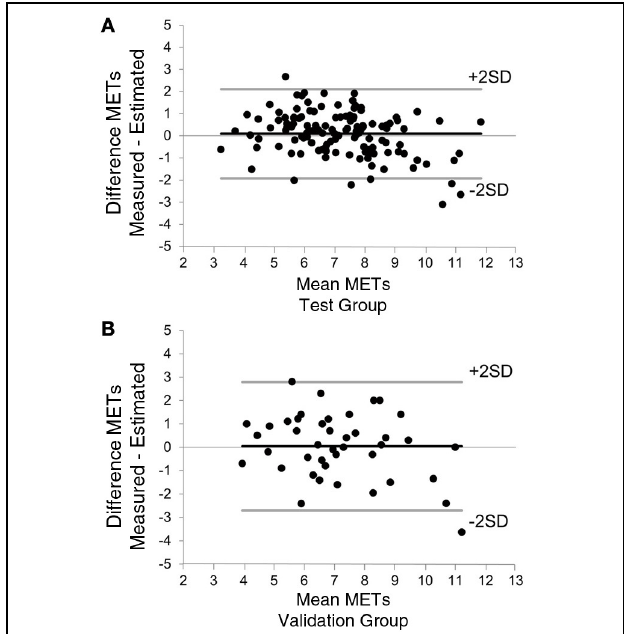
FIGURE 2 | Bland-Altman plot for predicted and measured MET peak in both test (A) and validation (B) groups. The bold black lines indicate the mean difference between measured and predicted MET peak and the bold gray lines indicate the 95% limits of agreement ( ± 2 SD).